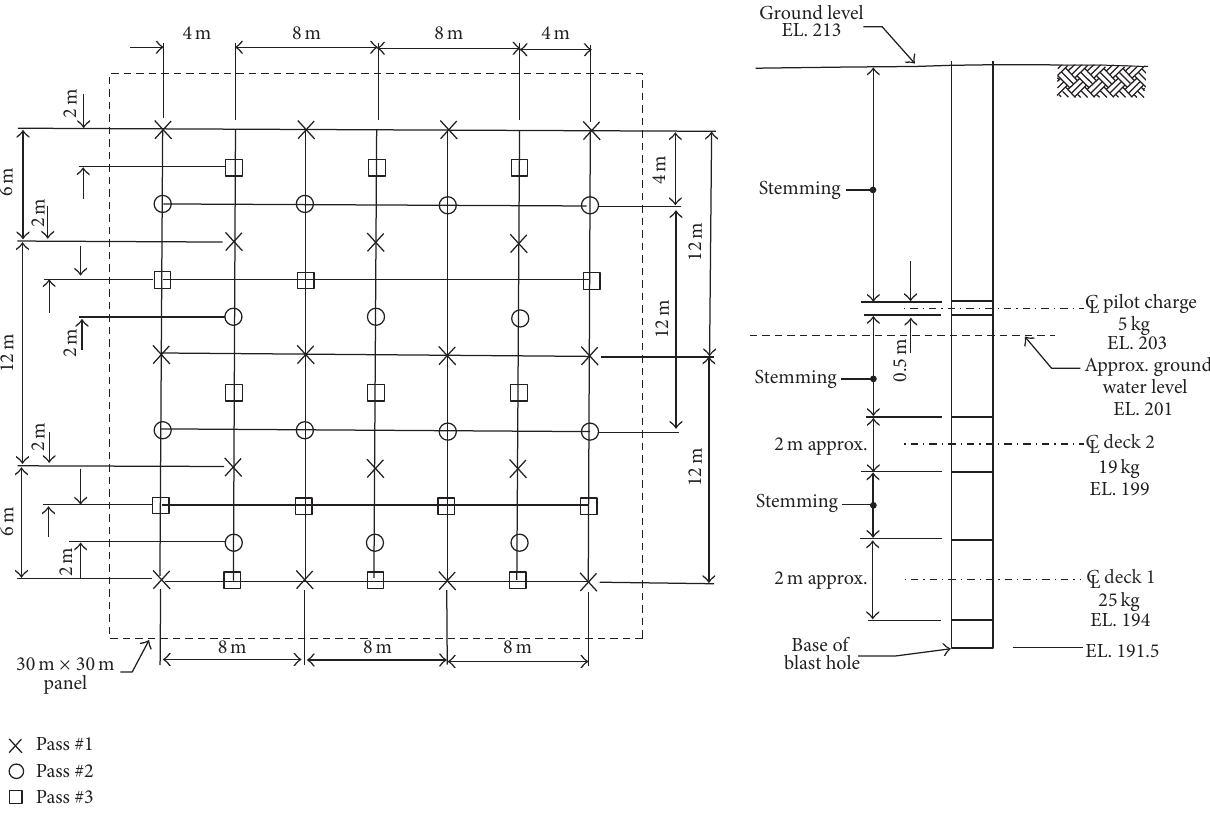
Figure 2: Arrangement of blast holes and loading a blast hole in Seymour dam project [8].